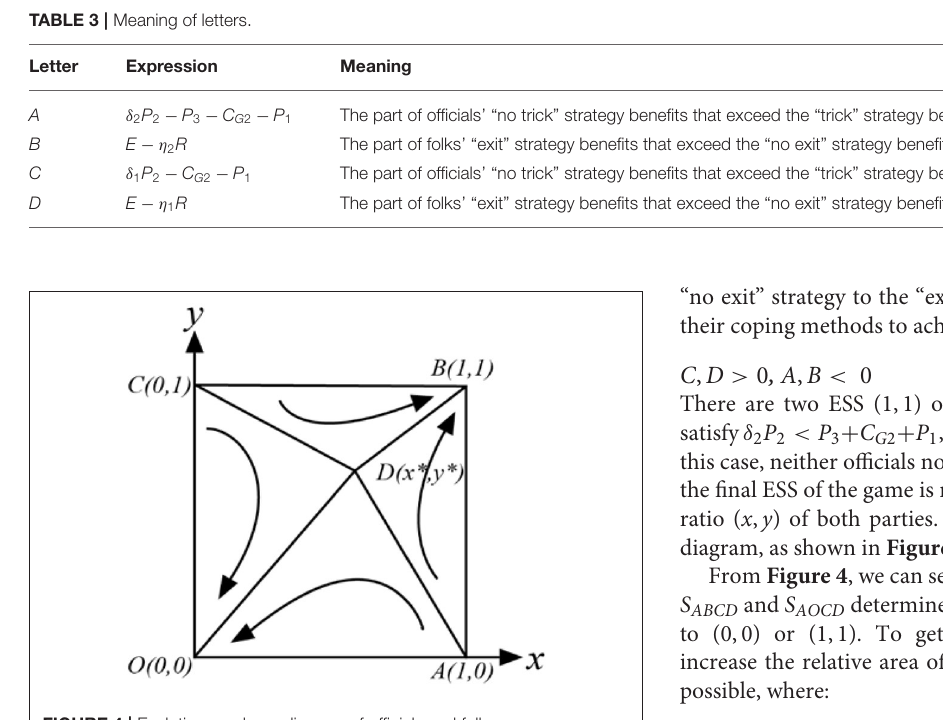
FIGURE 4 | Evolutionary phase diagram of officials and